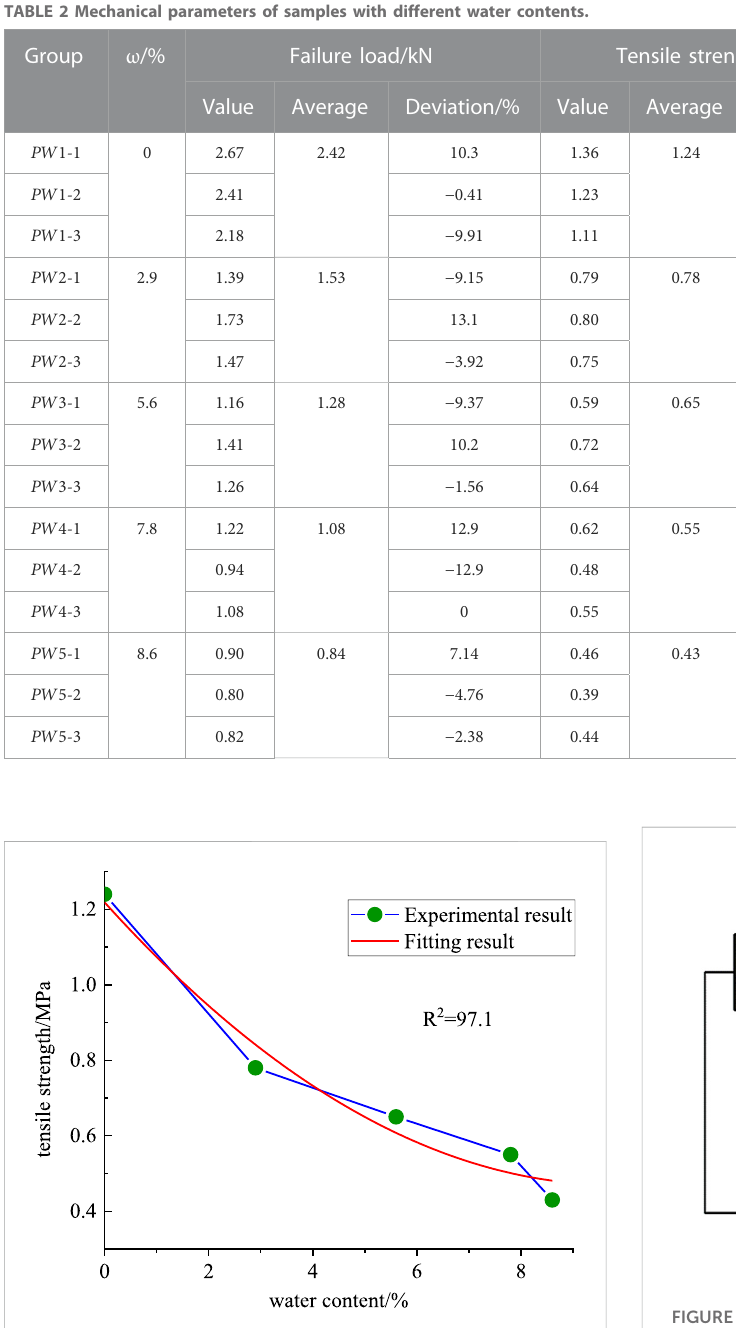
FIGURE 5 Brazilian disc deformation fi eld test system. 1 —